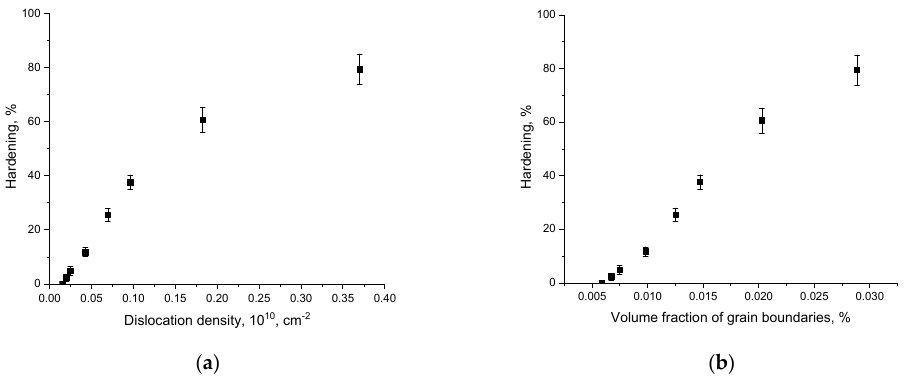
Figure 7. Results of a comparative analysis of the hardening coefficient depending on various hardening factors: ( a ) on the dislocation density ( b ) on the volume fraction of grain boundaries.